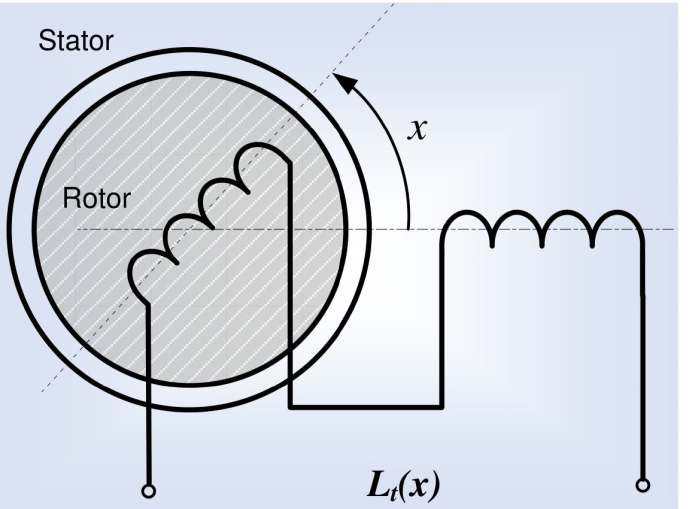
Figure 1. Electrical induction/synchronous machine configuration with varying inductance with respect to the angle x = ω t